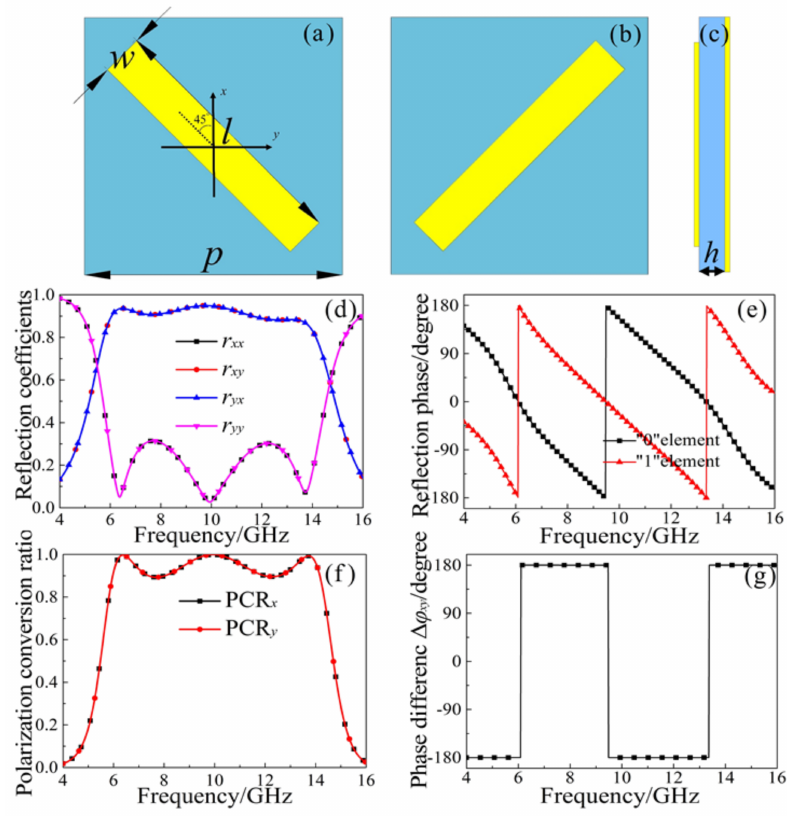
Figure 1. ( a ) The element “0” with an angle of 45 ◦ to the x -axis; ( b ) the element “1” rotated 90 ◦ counterclockwise about the z -axis; ( c ) the side view of the basic unit; ( d ) the reflection coefficient of elements “0” and “1” under normal x - and y -polarized incidence; ( e ) the reflection phase of cross-polarized wave; ( f ) the linear polarization conversion ratio of x - and y -polarized wave; ( g ) cross-polarization reflection phase difference of elements “0” and